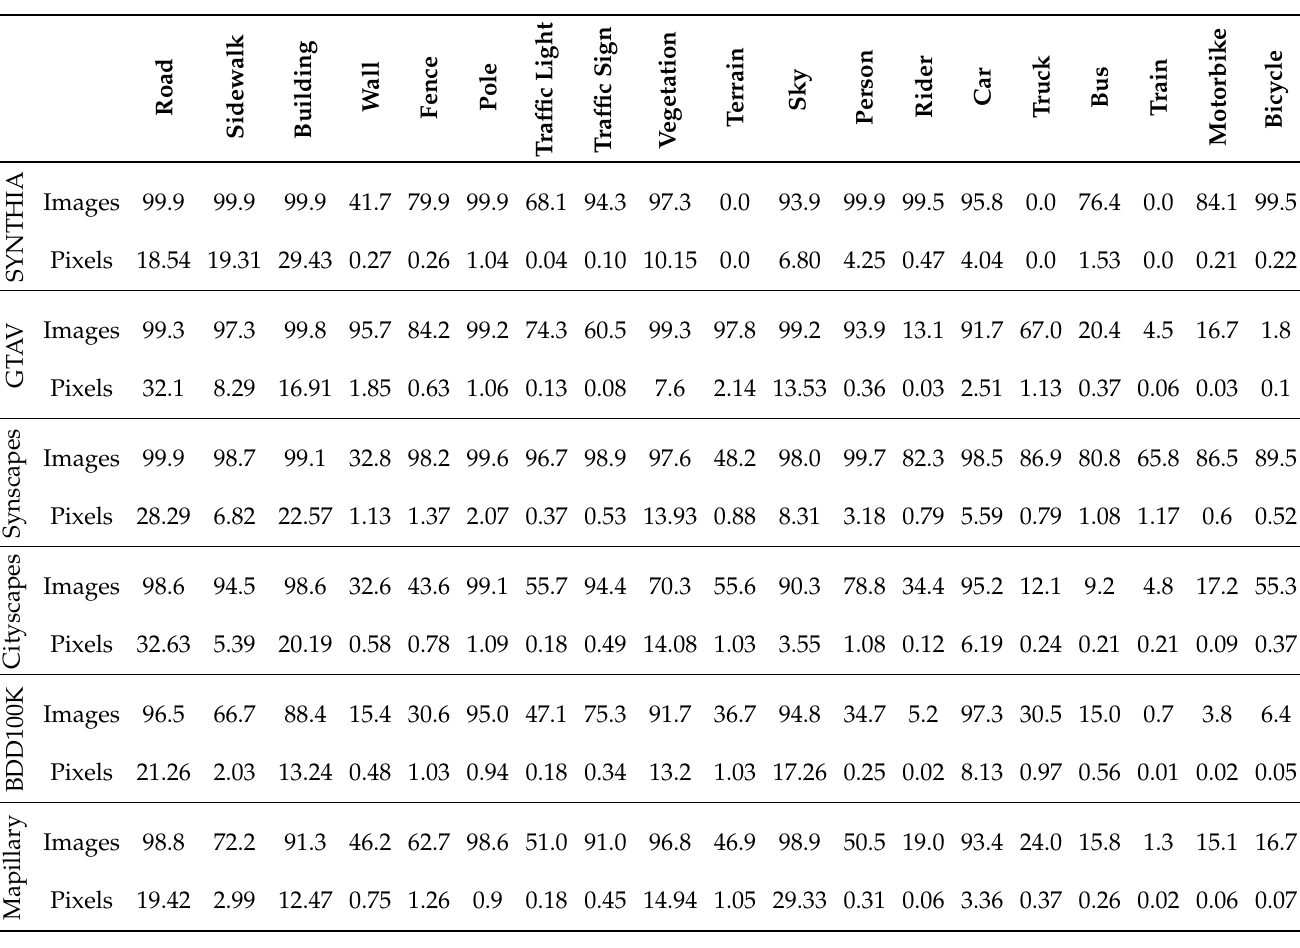
Table A1. Content statistics for the considered datasets. For each class, we indicate the percentage (%) of: (1) Images containing samples of the class, and (2) Pixels in the dataset with the class